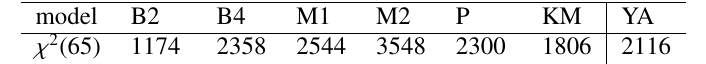
Table 1. χ 2 for 65 kaonic atoms data points from potentials based on single-nucleon amplitudes.